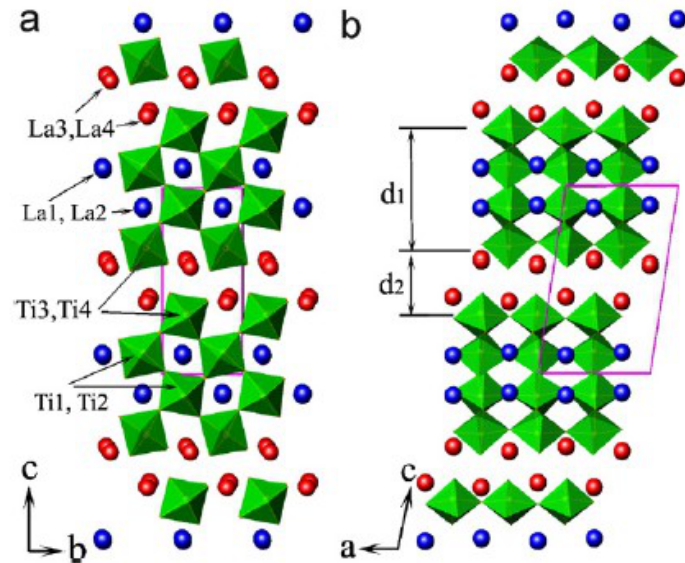
Figure 2. Schematic crystal structure of La ( b ) [010] directions, reprinted with permission from [20]. Copyright 2006